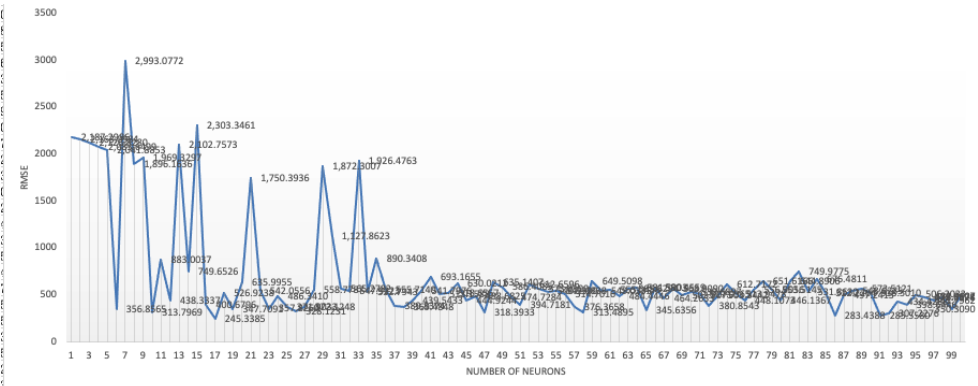
Figure 4. RMSE of ARMA-CNNLSTM forecasts using different model parameters in the validation set of Bitcoin closing prices